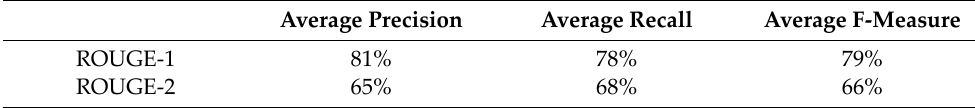
Table 10. ROUGE‑N (N = 1, 2) evaluation measures.